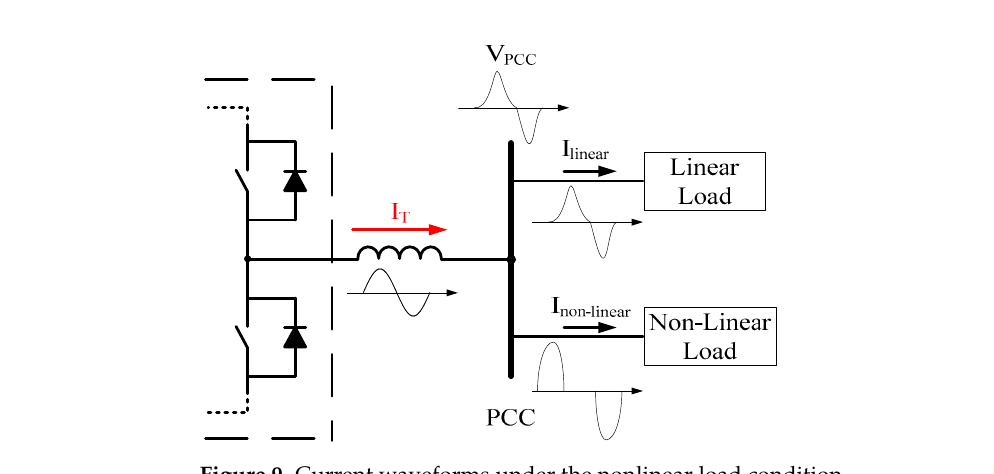
Figure 9. Current waveforms under the nonlinear load condition.